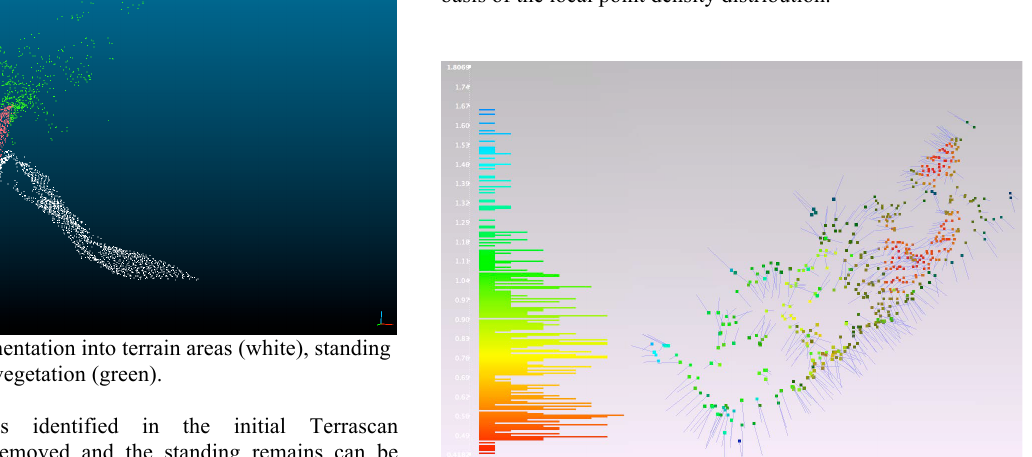
Figure 8. Points coloured by density and normal direction represented as vectors. Individual walls are distinguished in this example on the basis of normal